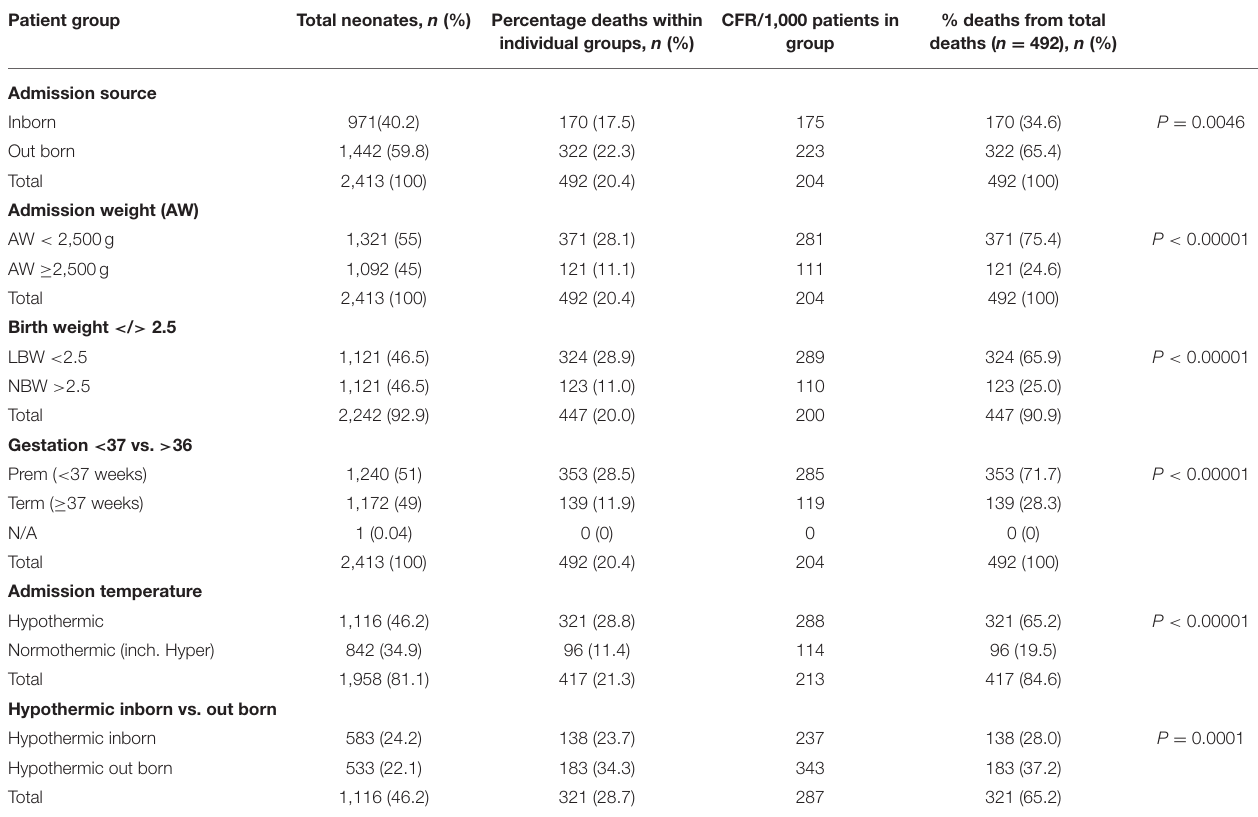
TABLE 4 | Univariate comparisons (Chi 2